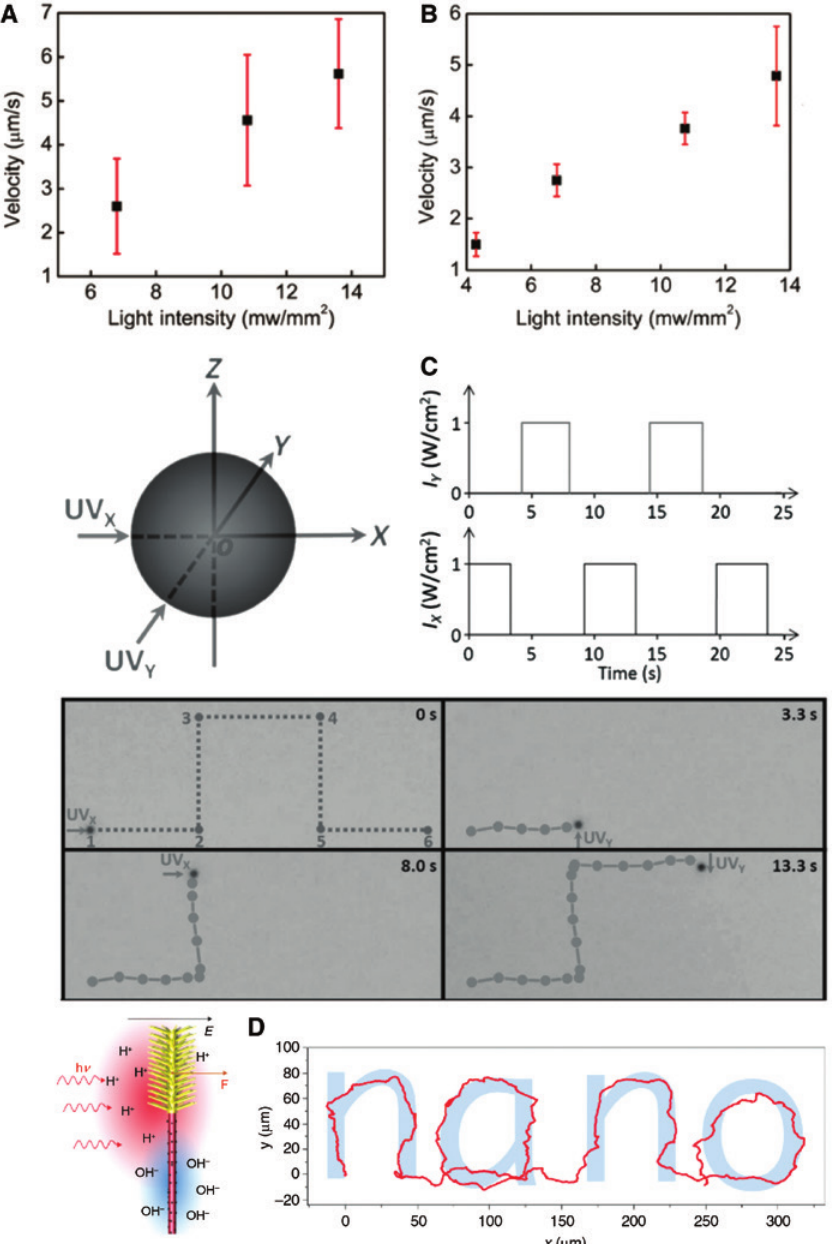
Figure 15: Micro/nanomotors’ motion controlled by light irradiation. (A) and (B) present the dependence of micro/nanomotors’ motion speed upon light intensity for Cu O/Au and Si/Au micromotors, respectively [74, 75]. Copyright 2017, The Royal Society of Chemistry. 2 (C) Motion direction controlled by the incident light directions for TiO micromotor [78]. Copyright 2016, Wiley-VCH. (D) Schematics of the 2 asymmetric branched Si/TiO micromotor alignment mechanism with side illumination and its following of the “nano” shape navigated by 2 light [70]. Copyright 2016, Nature Publishing